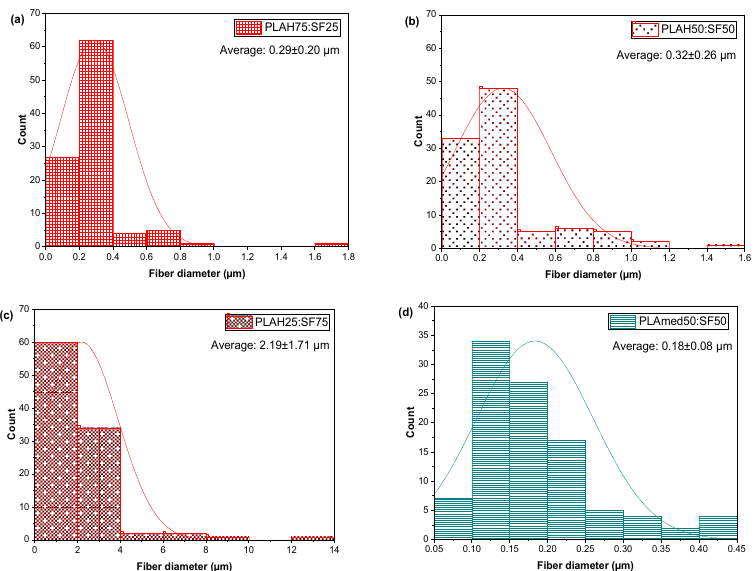
Figure 4. Histograms of electrospun fibers ( a ) PLAH75:SF25, ( b )PLAH50:SF50; ( c ) PLAH25:SF75 and ( d ) PLAmed50:SF50.